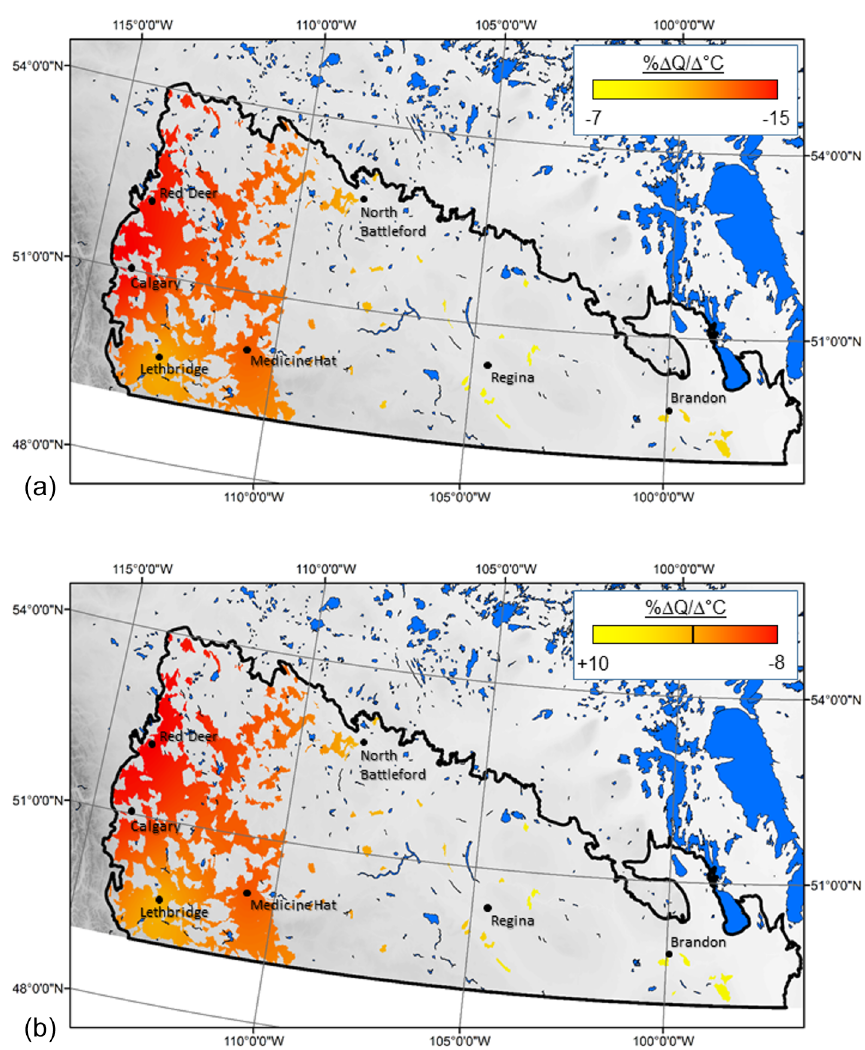
Figure 11. Sensitivity of annual runoff from HEG basins to warming assuming no change in precipitation (a) and a 30% increase in mean annual precipitation (b) . Note that the black bar in the legend for (b) denotes the colour at which there is no